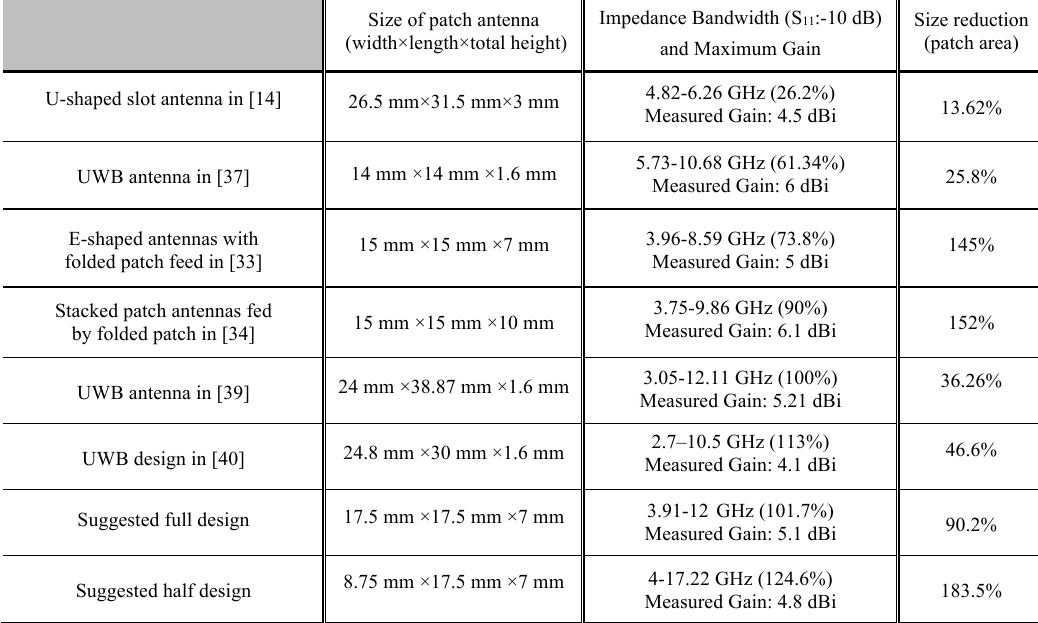
TABLE II. Comparison the performance of suggested designs with other studies Size of patch antenna (width×length×total